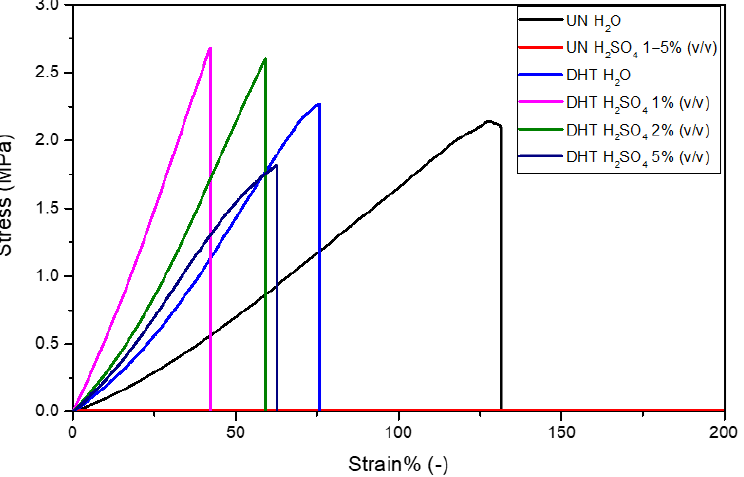
Figure 5. Representative stress-strain curves of uncrosslinked and cross-linked collagen matrices in the presence of water and sulfuric acid 1–5% ( v / v ).